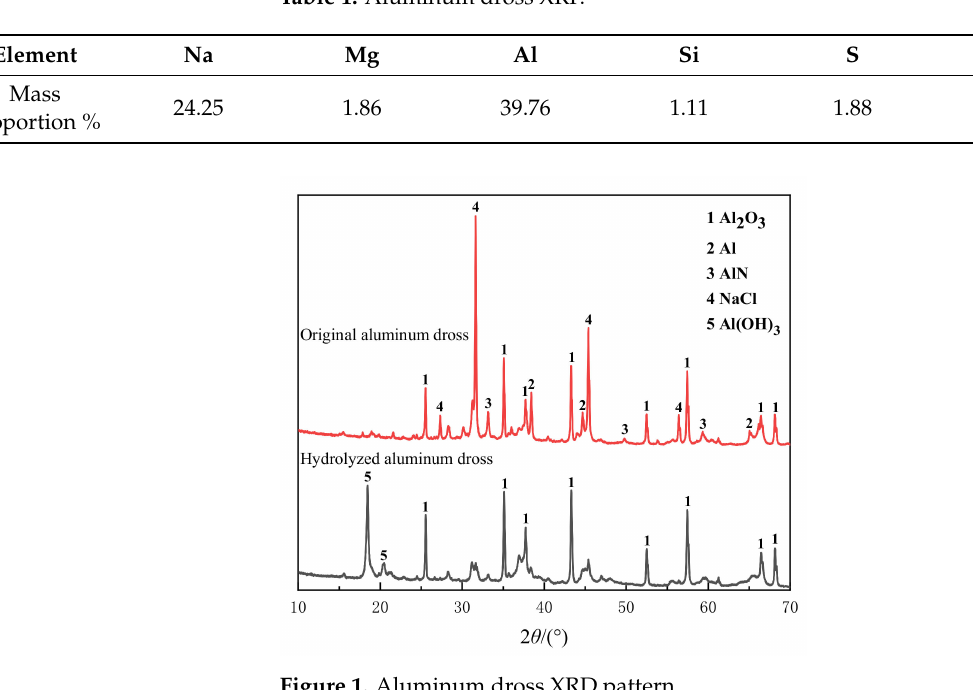
Figure 1. Aluminum dross XRD pattern.